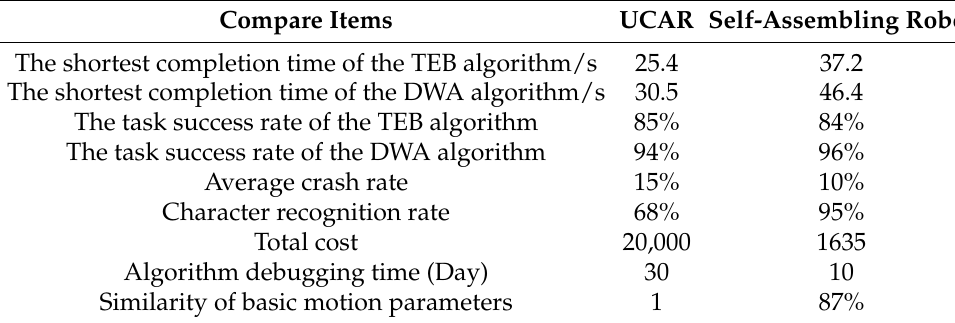
Table 9. Performance comparison of self-assembling robot and UCAR